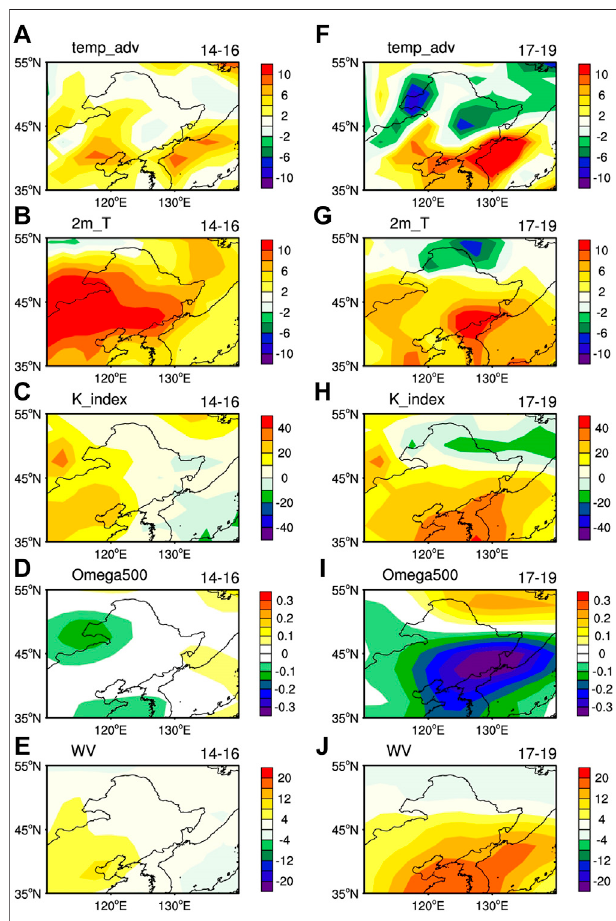
FIGURE 4 | Horizontal temperature advection (unit: K day − 1 ), temperature (unit: ° C), K-index (unit: ° C), 500-hPa Omega (unit: 10 – 2 Pa s − 1 ), and precipitable water for the entire atmosphere (kg m − 2 ) during (A – E) 14 – 16 November 2020 and (F – J) 17 – 19 November 2020.